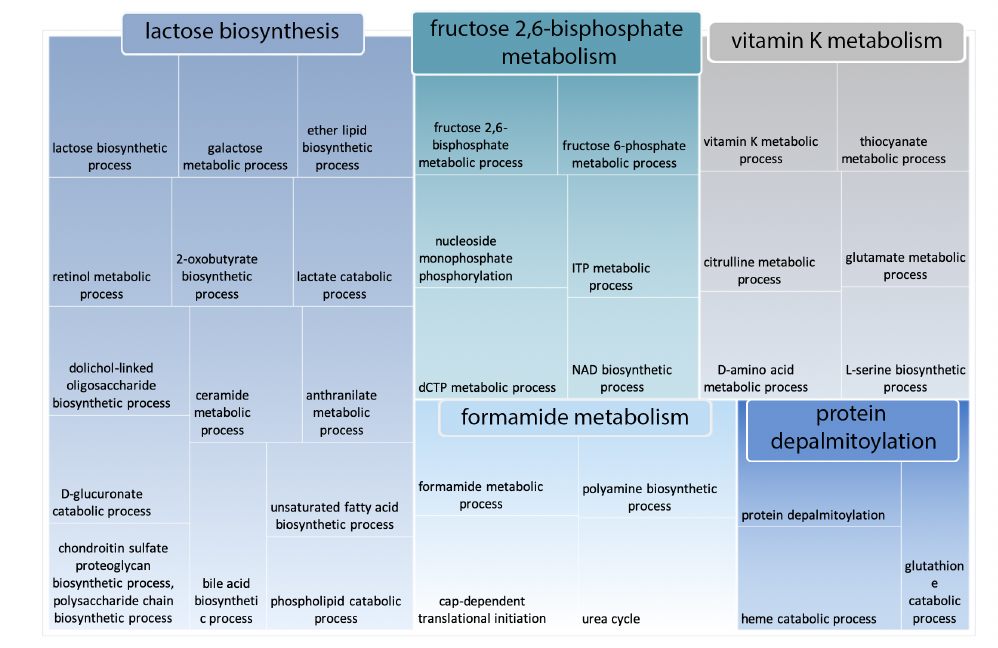
Figure 7. REVIGO representation of all GO terms included within the category “glutathione catabolism”, which comprises the largest cluster of GO terms that are more enriched in Camelus disordered proteins compared to those of Homo sapiens